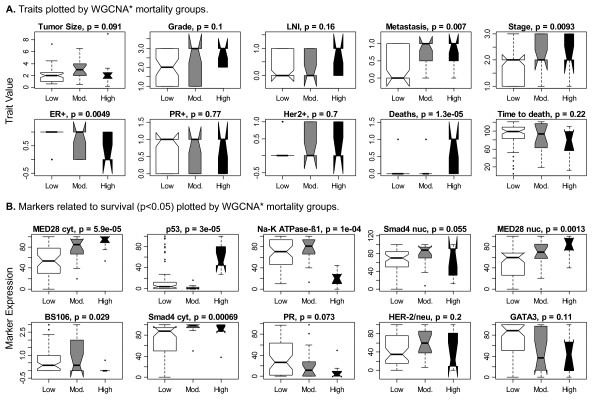
Variable and marker boxplots by WGCNA* mortality group. Kruskal-Wallis p-values are reported for the comparison of each variable and marker to the WGCNA* patient groups, where the WGCNA* patient groups are color coded to indicate low (white), moderate (grey) and high (black) mortality. A. Metastasis, stage, ER+ and death are significantly related to the WGCNA* groups (p < 0.05). B. The top 10 markers related to survival that achieved significance at p < 0.05 in a univariate Cox proportional-hazards model when dichotomized at an optimal cut-point. The boxplots indicate that no variable or marker by itself can define the WGCNA* groups. Abbreviations are as follows, "LNI" stands for Lymph Node Involvement, "cyt" indicates the TMA marker was expressed in the cytoplasm and "nuc" indicates nuclear expression.